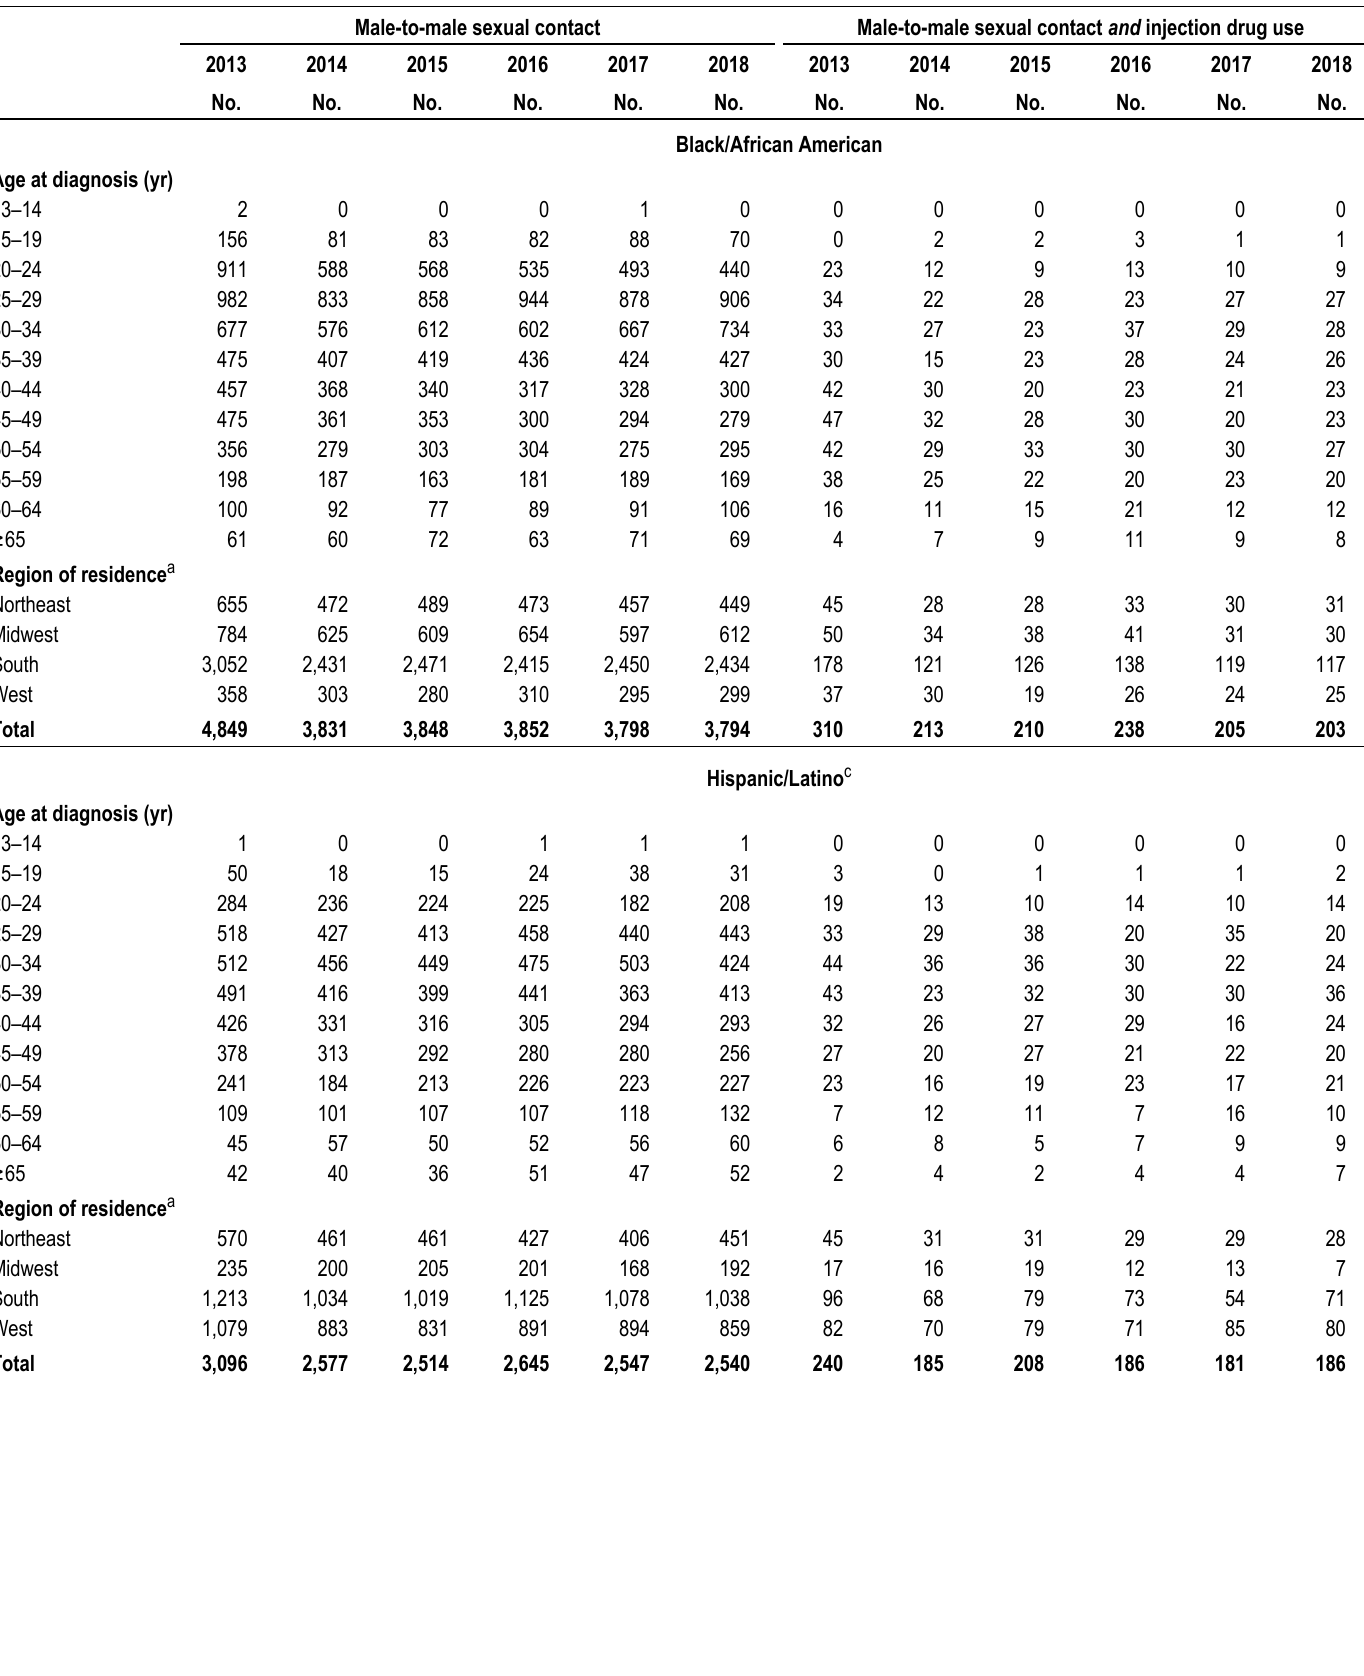
Table 10a. Stage 3 (AIDS) attributed to male-to-male sexual contact and male-to-male sexual contact and injection drug use, by selected characteristics, 2013–2018—United States (cont) Male-to-male sexual